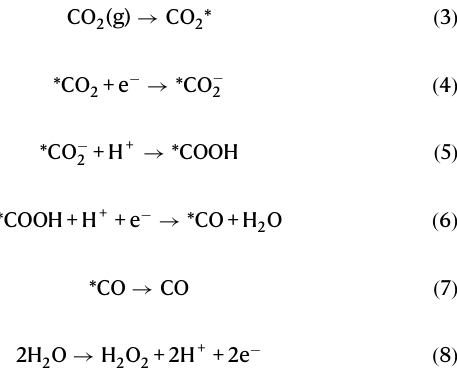
the CO evolution rates afford to be 8.6 μ mol h − 1 g − 1 for MIL-101(Fe)- NH 2 , 15.3 μ mol h − 1 g − 1 for UiO-66(Zr)-NH 2 , and 5.2 μ mol h − 1 g − 1 for